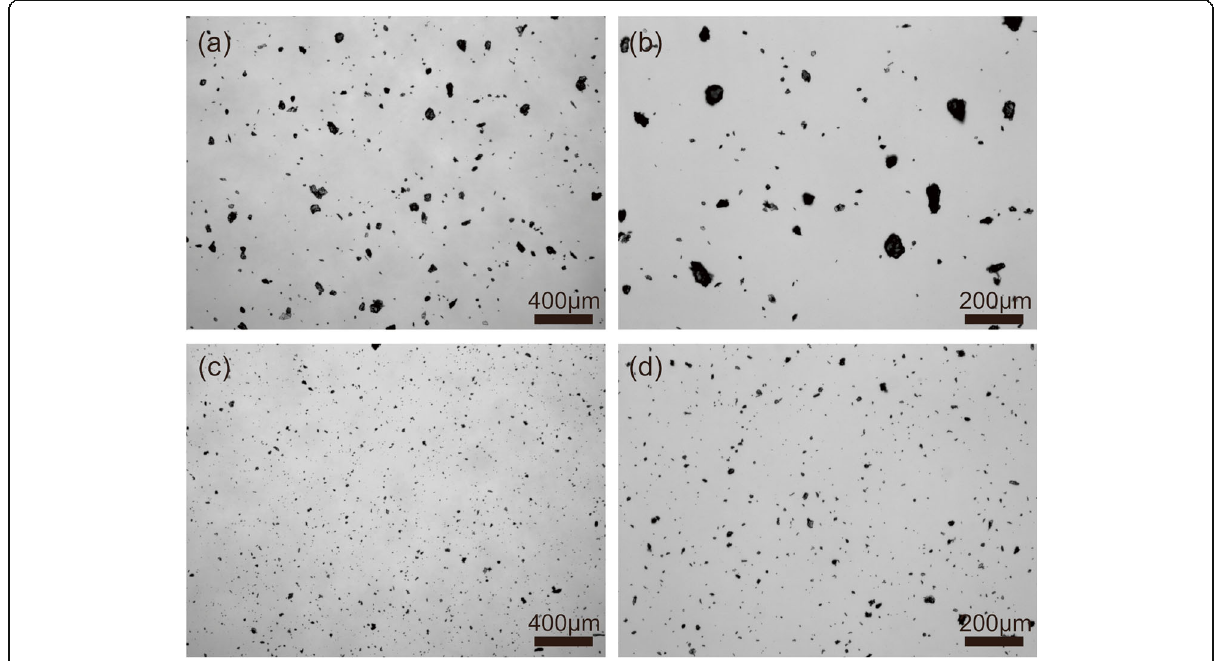
Fig. 6 Characteristic particles in samples from a , b 209.75 cm depth (turbidite T25, silty sand) and c , d 207.25 cm depth in PC04 (silt) observed using Morphologi-G3. Mean grain sizes and sand percentages of each 0.5 cm-thick sample are shown in Fig. 8c and Table 1